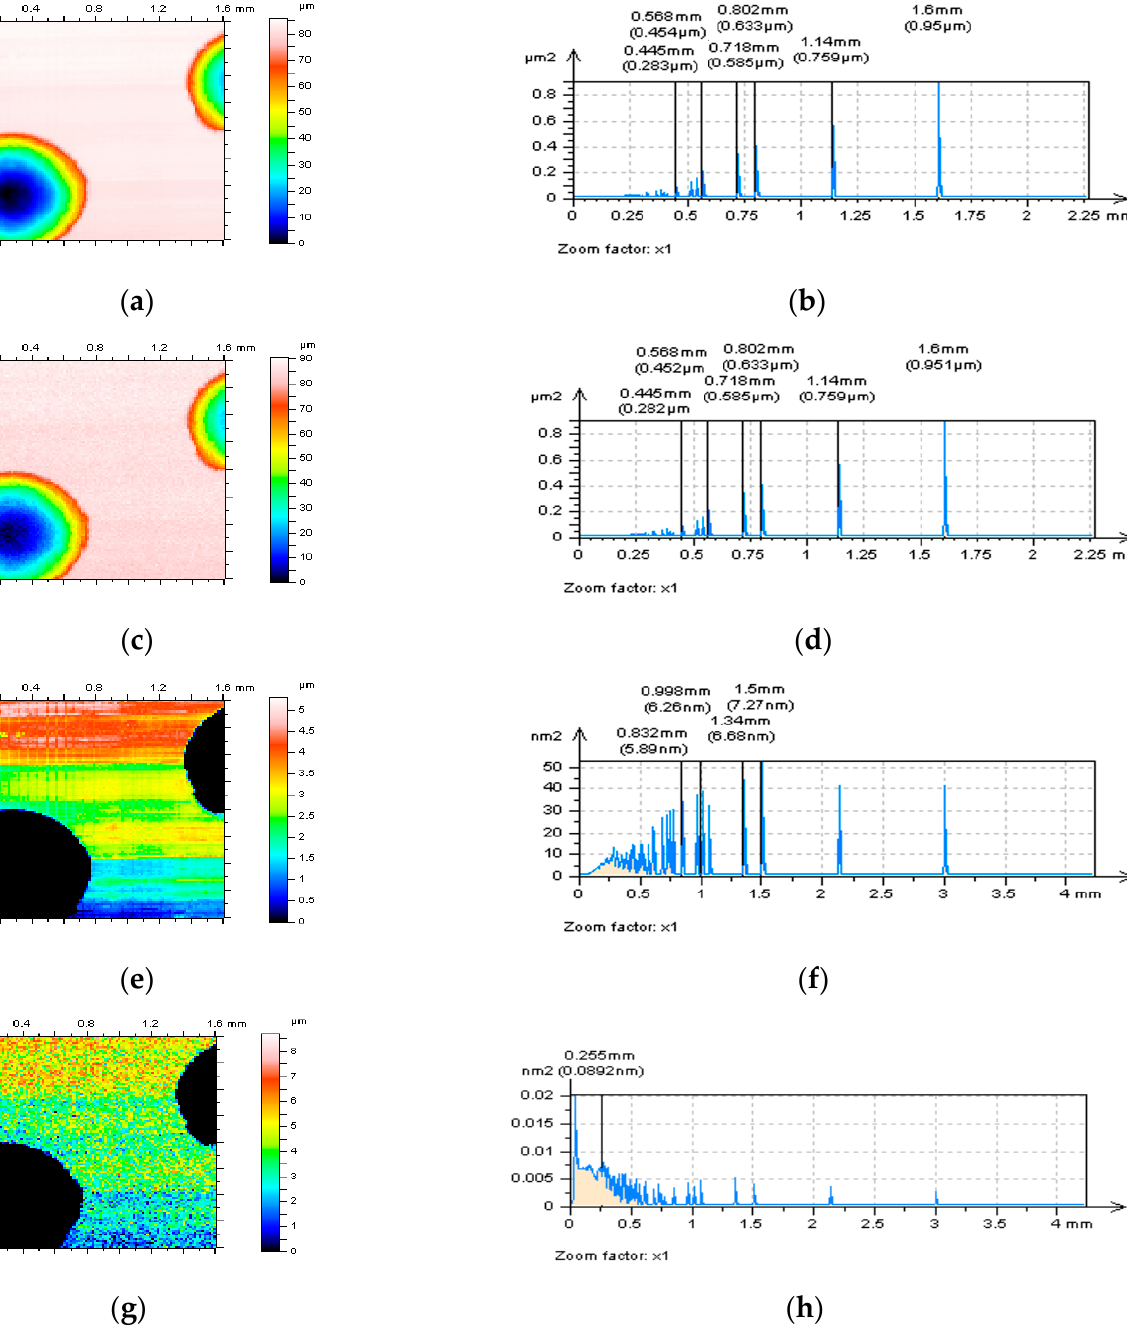
Figure 4. Examples of isometric views (left column) cylinder liner surface textures and its PSDs (right column) with two separate dimples, measured by stylus instrument with 0.3 mm/s ( a , b , e , f ) and 0.7 mm/s ( c , d , g , h ) velocity and the same details after application of the PVTM ( e – h ) correspondingly.